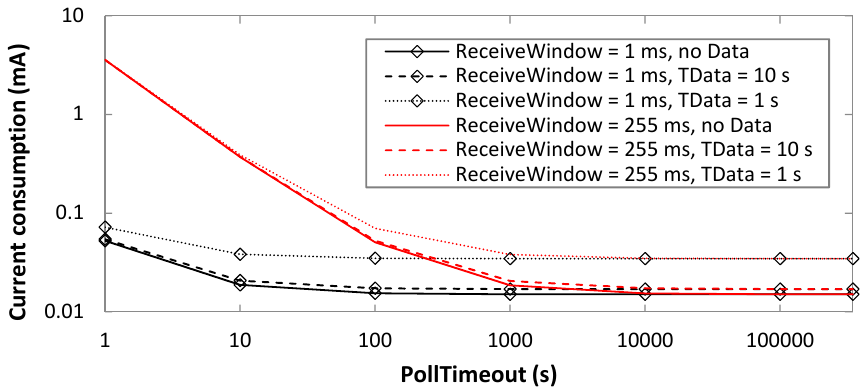
Figure 9. Impact of T Data on the average current consumption of the BM-LPN, for ReceiveWindow settings of 1 ms and 255 ms, as a function of PollTimeout.